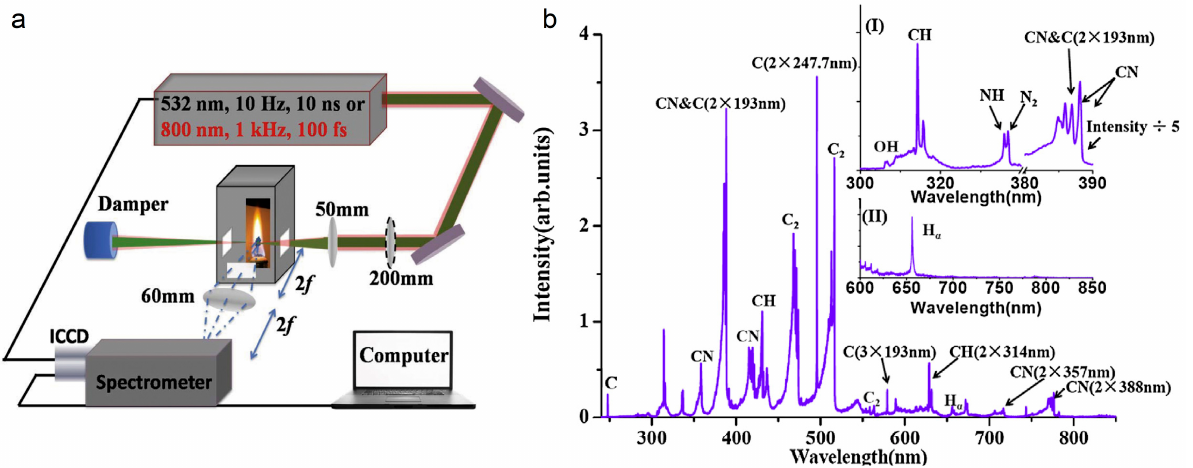
Figure 21. ( a ) Experimental setup and ( b ) typical FIPS spectrum ranging from 240 to 850 nm of the ethanol-air flame in atmosphere [327]. Insets: (I) zoomed-in spectrum in the range of 300–345 nm, and (II) spectrum obtained with a high-pass fi lter.